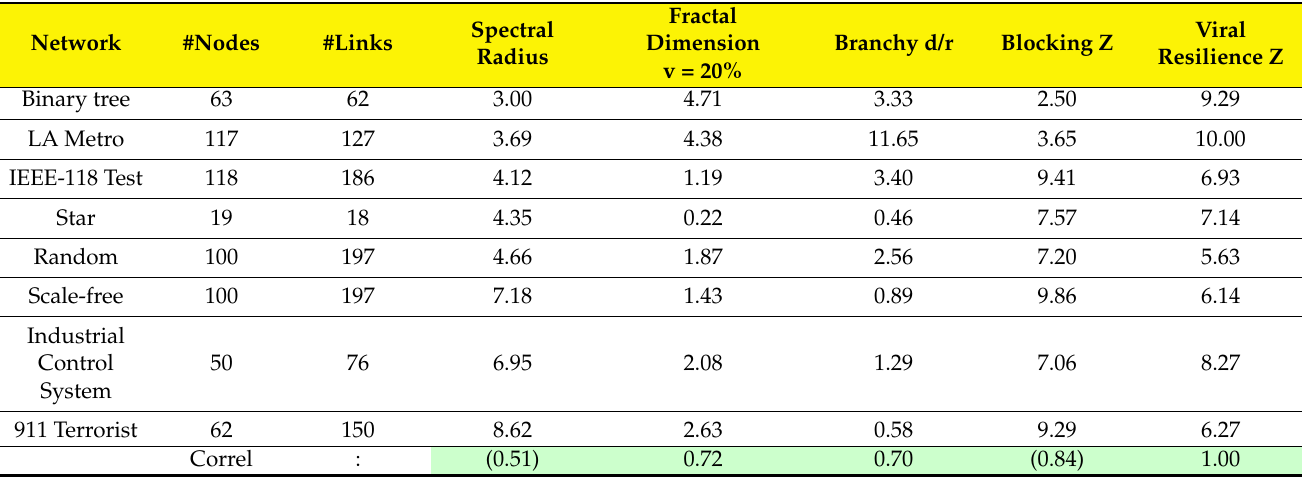
Table 1. Properties of a select collection of networks with widely variable structure. Fractal dimension obtained by simulations with v = 0.20. Correlations are with viral resilience